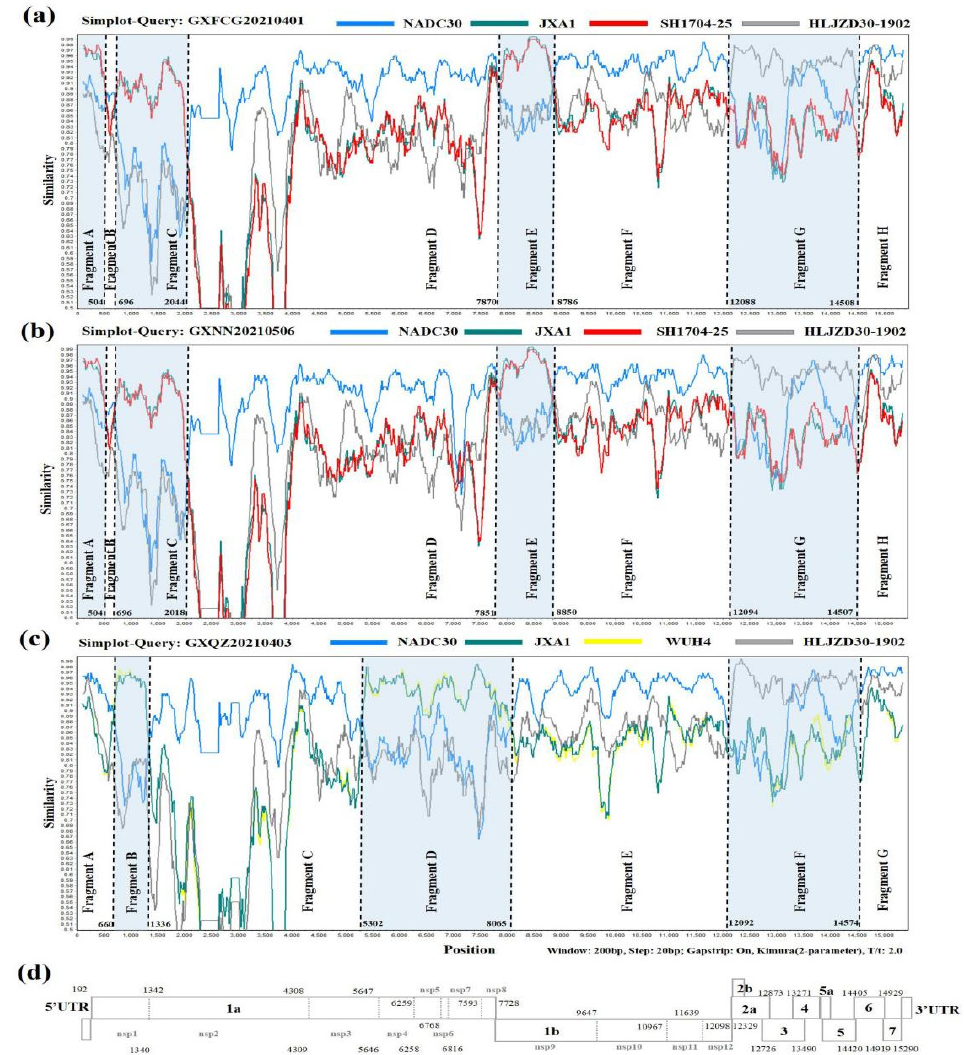
Figure 3. Simplot was utilized to compare the similarities of GXFCG20210401 ( a ), GXNN20210506 ( b ) and GXQZ20210403 ( c ) to potential parental viruses, respectively. Recombinant breakpoints are displayed as black virtual lines. The background color of the primary parental areas (NADC30-like) is in white, whereas that of the minor parental areas (HP-PRRSV- and NADC34-like) is in blue. NADC30, JXA1, SH1704-25 and HLJZD30-1902 are depicted by blue, green, red and grey colorations in the plotted similarity curves, respectively. ( d ) The whole genome structure of PRRSVs, which shows the location of the 10 open reading frames and non-structural